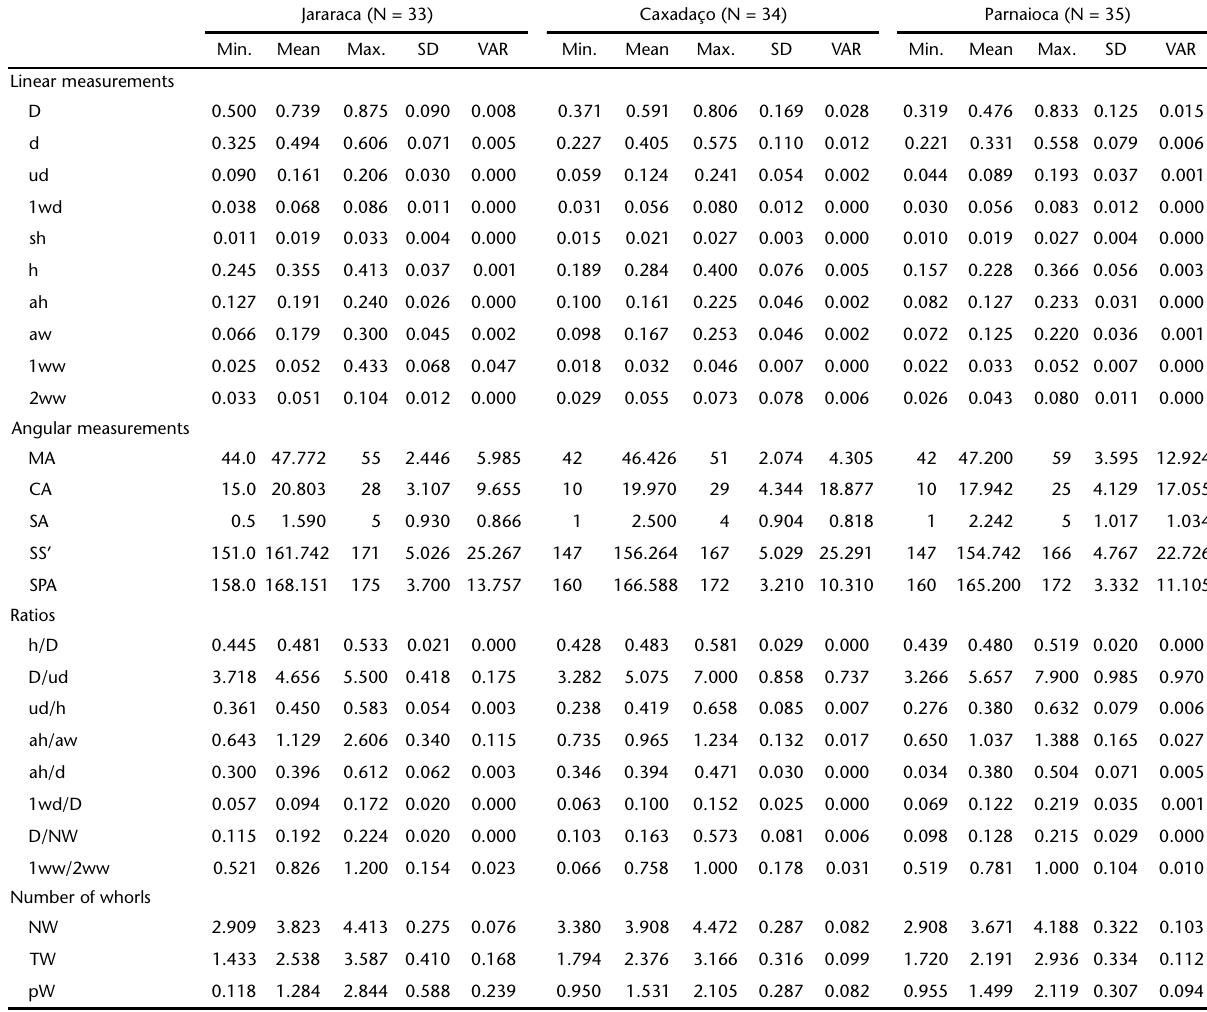
Table II. Descriptive statistics of morphometric and meristic variables and ratios for Happiella cf. insularis collected from three areas on Ilha Grande. Linear measurements (cm): (D) maximum diameter, (d) smaller diameter, (ud) umbilical diameter, (1wd) first whorl diameter, (ah) aperture height, (sh) spire height, (h) shell height, (aw) aperture width, (1ww) first whorl width, (2ww) second whorl width. Angular measurements (degrees): (CA) columellar angle, (MA) maximum angle, (SPA) spire angle, (SA) sutural angle, (SS’) lower sutural angle. Ratios: (D/ud) maximum diameter/umbilical diameter, (D/NW) maximum diameter/total number of whorls, (ud/h) maximum diameter/umbilical diameter, (1wd/D) first whorl diameter/maximum diameter, (h/D) shell height/maximum diameter, (aw/d) aperture height/smaller diameter, (ah/aw) aperture height/aperture width. Number of whorls: (pW) number of protoconch whorls, (TW) number of teleoconch whorls, (NW) total number of whorls. (N) sample size, (SD) standard deviation, (VAR) variance. Jararaca (N = 33) Caxadaço (N = 34) Parnaioca (N = 35) Min. Mean